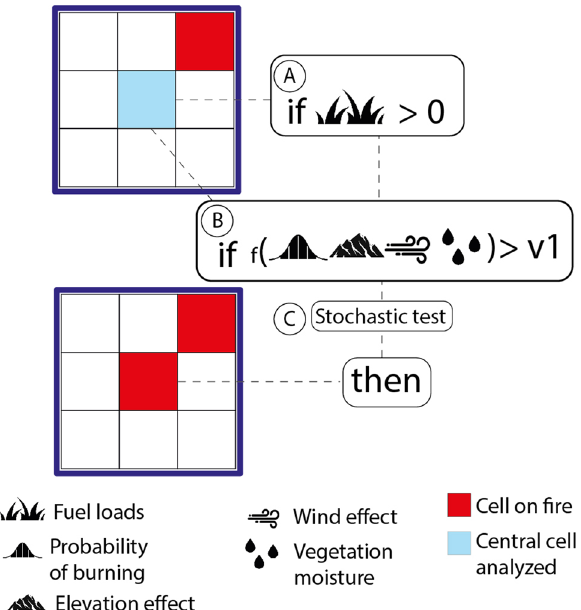
Figure 4. The flammability module. ( A ) test for the presence of fuel loads; ( B ) flammability test combining the probability of burning, topographic and wind effects and vegetation moisture; ( C ) stochastic test to produce radial fire fronts.